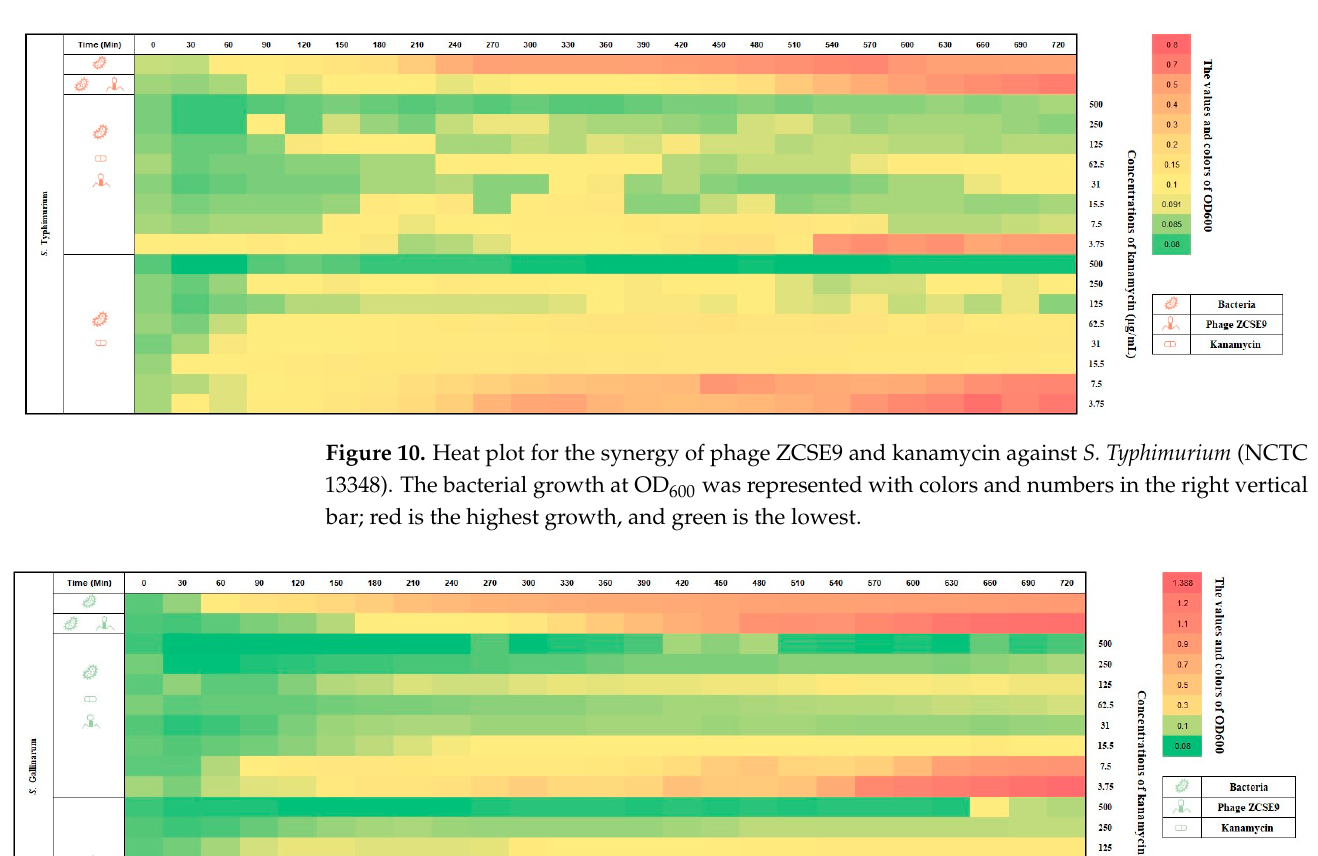
Figure 9. Heat plot showing the synergy of phage ZCSE9 and kanamycin against S. Typhi (NCTC 160). The bacterial growth at OD 600 was represented with colors and numbers in the right vertical bar; red is the highest growth, and green is the lowest.